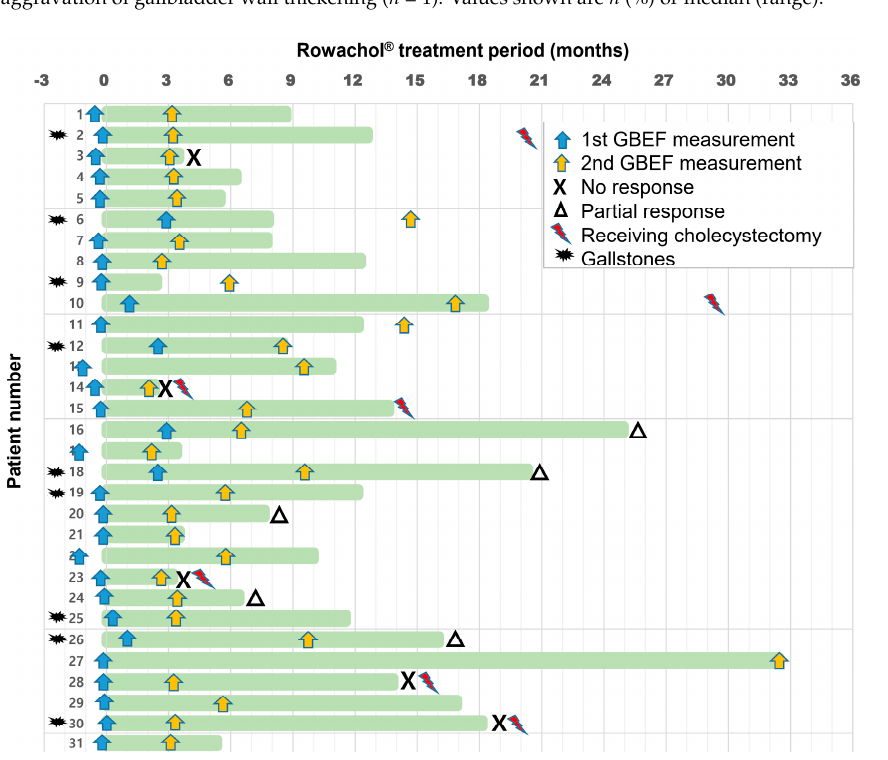
Figure 2. Bar chart for the timetable of GBEF measurement and Rowachol treatment. The horizontal axis on the top indicates time interval (months) from the start date of Rowachol treatment. Rowachol treatment period is defined as the length of green bar on each patient of the vertical axis. Blue and yellow arrows indicate the time points of initial and follow-up GBEF measurements. For clinical response, “X” on the right end of the green bar indicates “no response” and “triangle” indicates “partial response” for each patient. Among five (16.1%) patients with no response, four finally received cholecystectomy (red lightning bolt). The other three patients finally underwent cholecystectomy, due to symptom recurrence after stopping Rowachol treatment (Case 2 and 10), and aggravation of GB wall thickening (Case 15). Additionally, the black explosive star indicates the nine patients with GB stones or sludge on initial transabdominal ultrasonography examination. GBEF, gallbladder ejection fraction; GB,